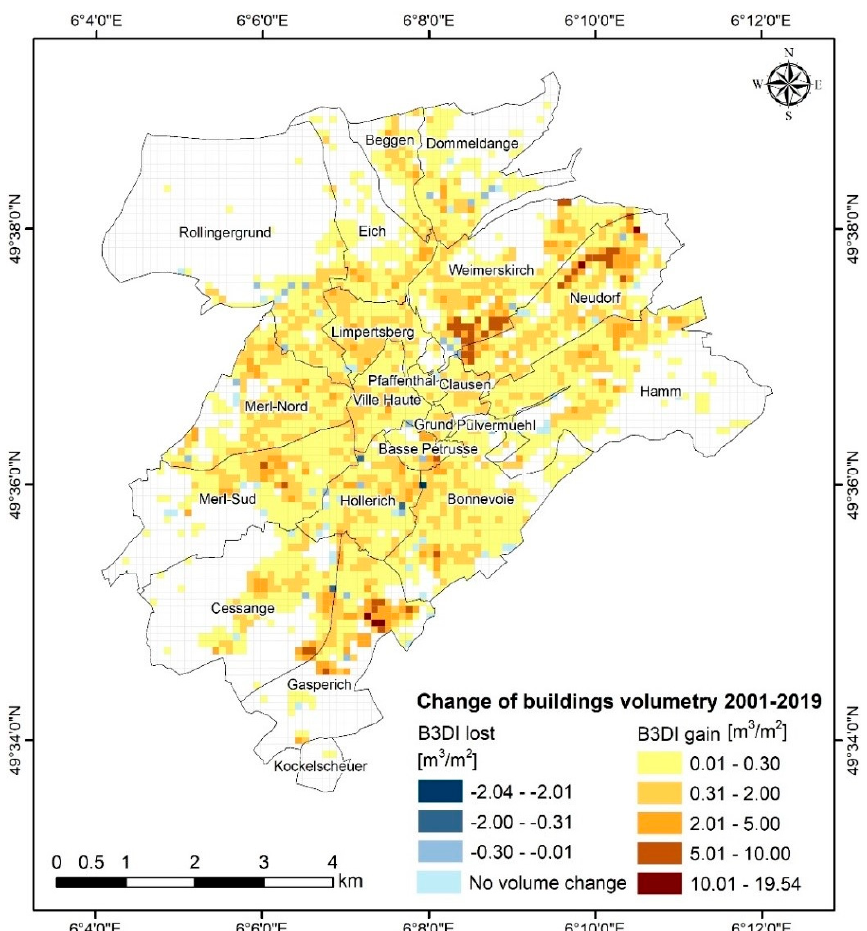
Figure 14. Change of buildings volumetry between 2001 and 2019 in Luxembourg City in a grid (100 × 100 m).